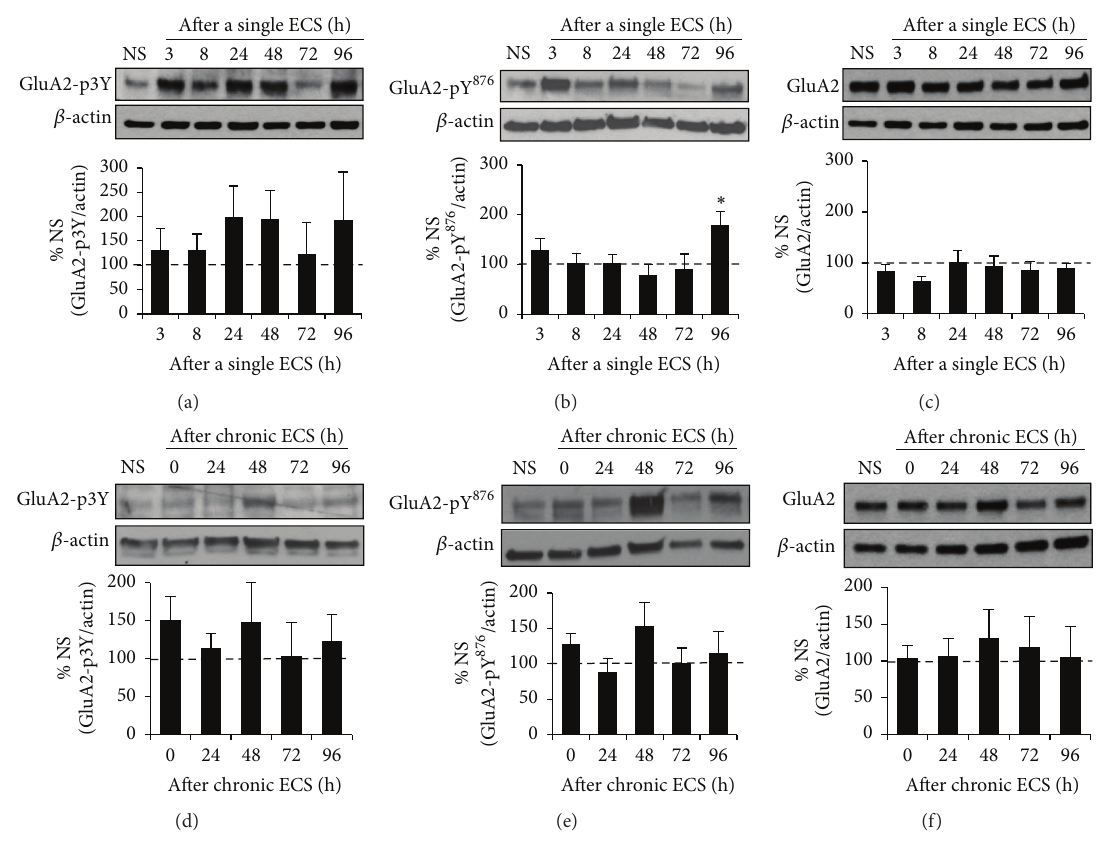
Figure 3: A single ECS but not chronic ECS increases the level of Tyr 876 -phosphorylated GluA2 in the hippocampus. Immunoblot analysis for phosphorylation of GluA2 at Tyr 876 (Y 876 ) or 3Tyr (3Y: Tyr 869 , Tyr 873 , and Tyr 876 ) and total GluA2 expression in the hippocampal crude membrane (P2) fraction following a single ECS ( 𝑛 = 5 rats per time point) (a–c) and chronic ECS ( 𝑛 = 5 rats for 72 h time point and 𝑛 = 6 rats per all other time points) (d–f). The ratio of the phosphorylated GluA2 band intensity over the 𝛽 -actin band intensity (a-b, d-e) and the